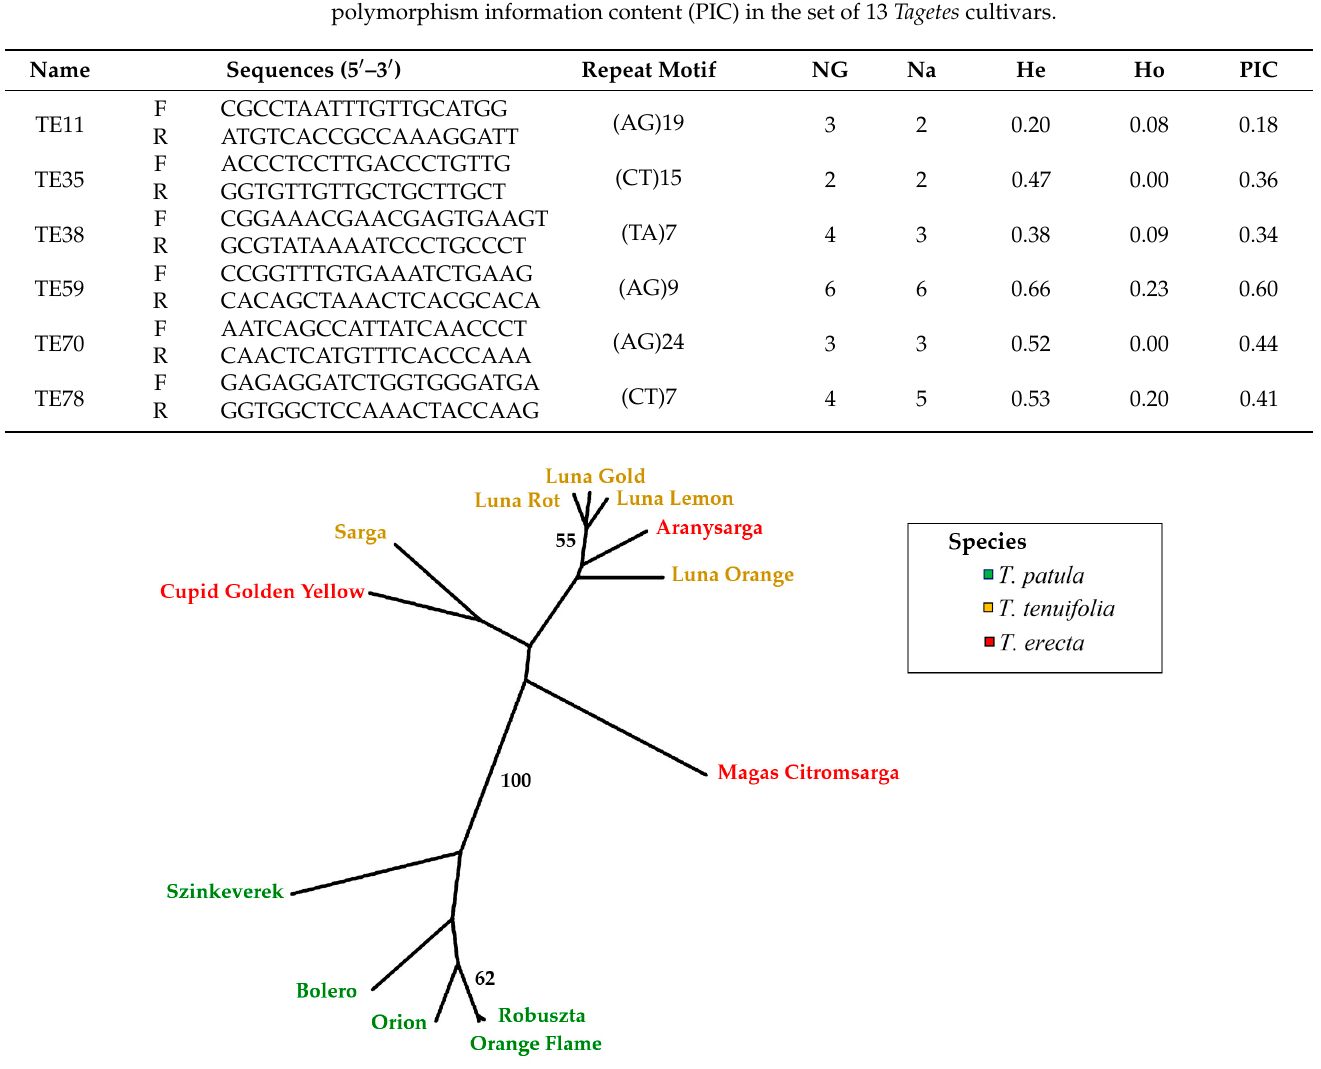
Figure 8. Unrooted UPGMA phenogram of 13 Tagetes cultivars based on six polymorphic SSR markers. The species of each cultivar is identified with a different colour.